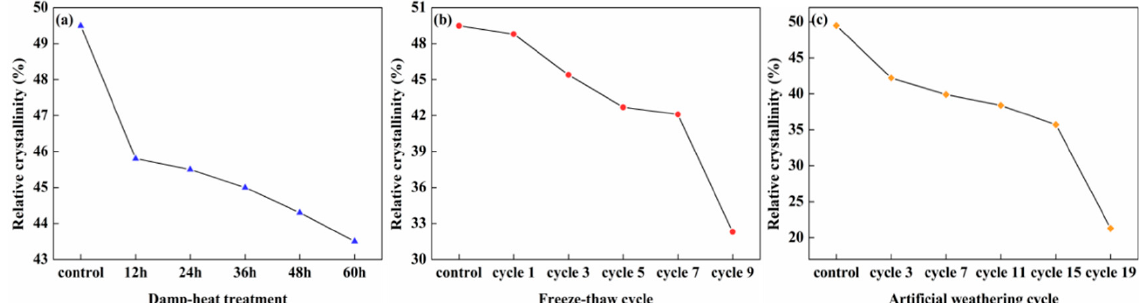
Figure 4. Relative crystallinity: ( a ) damp–heat treatment; ( b ) freeze–thaw cycle; and ( c ) artificial weathering cycle.